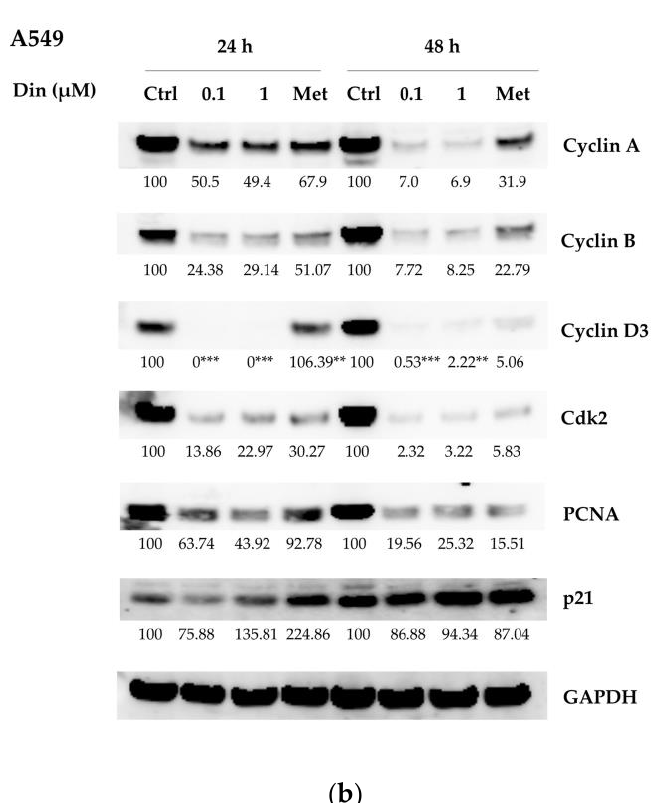
Figure 2. Dinactin down-regulated cell cyclins A, B, and D3, cdk2 and PCNA in Lu99 and A549 cells. Lu99 and A549 cells were treated with 0.1 and 1 µ M dinactin for 24 and 48 h. The levels of cell cycle-related proteins were examined by western blot analysis. Representative Lu99 cell results were shown, along with numbers indicating levels of cell cycle-related proteins compared to non-treated cells (expressed as 100), ( a ). GAPDH was used as a loading control. Those of A549 cells were shown ( b ). Metformin (24.5 mM) was used as a loading control and a positive control. The data are presented as the ± SD of three independent experiments and compared by the two-way ANOVA followed by the Bonferroni post-hoc test. * p < 0.05, ** p < 0.01, *** p < 0.001. Abbreviations: Ctrl, Control; Din, dinactin; Met, metformin; Cdk2, cyclin-dependent kinases; PCNA, proliferating cell nuclear antigen; GAPDH, glyceraldehyde 3-phosphate